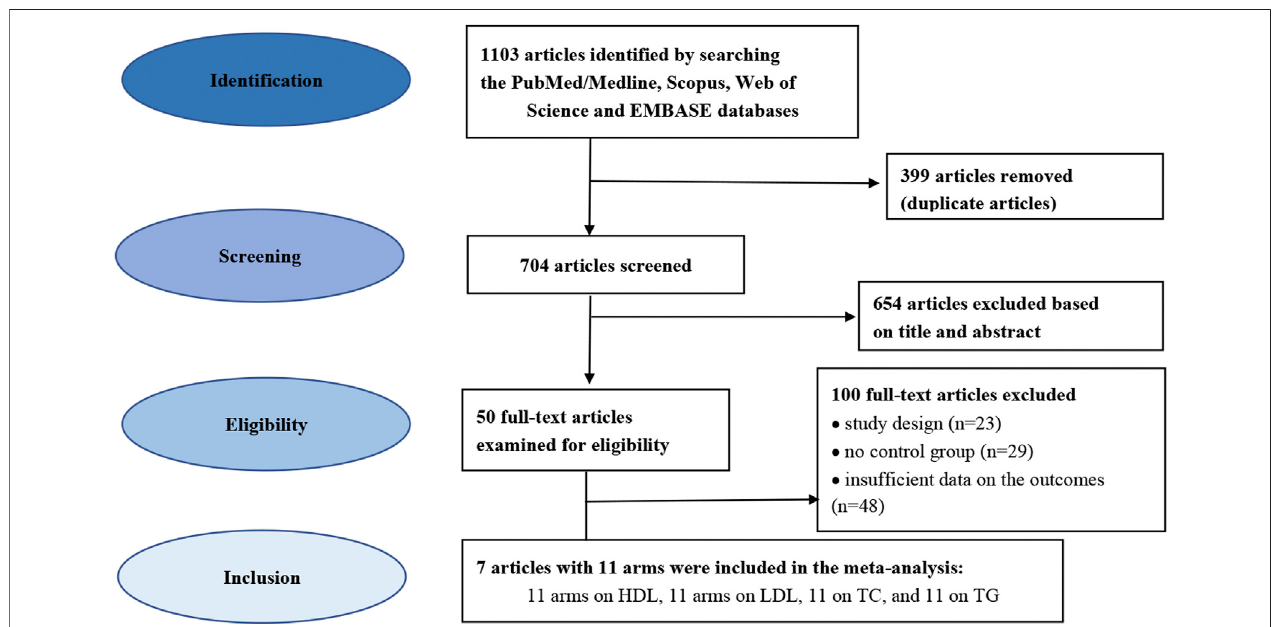
FIGURE 1 | Flowchart depicting the study selection and inclusion process for the present meta-analysis.